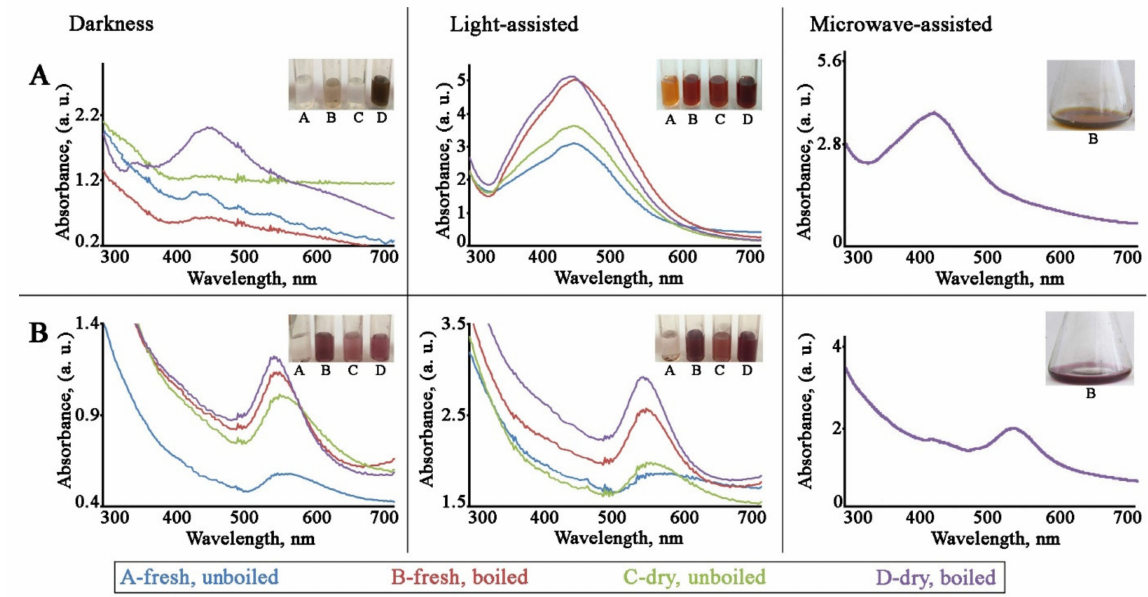
Figure 1. UV-visible spectra of AgNPs ( A ) and AuNPs ( B ) synthesized with L . erythrorhizon callus extracts under various conditions. The reactions were carried out either in the dark or under continuous illumination. Fresh and dried callus biomass was used for extract preparation. Extracts were boiled or left unboiled before mixing with AgNO 3 and HAuCl 4 . Biosynthesis was also performed using fresh and boiled extract under microwave